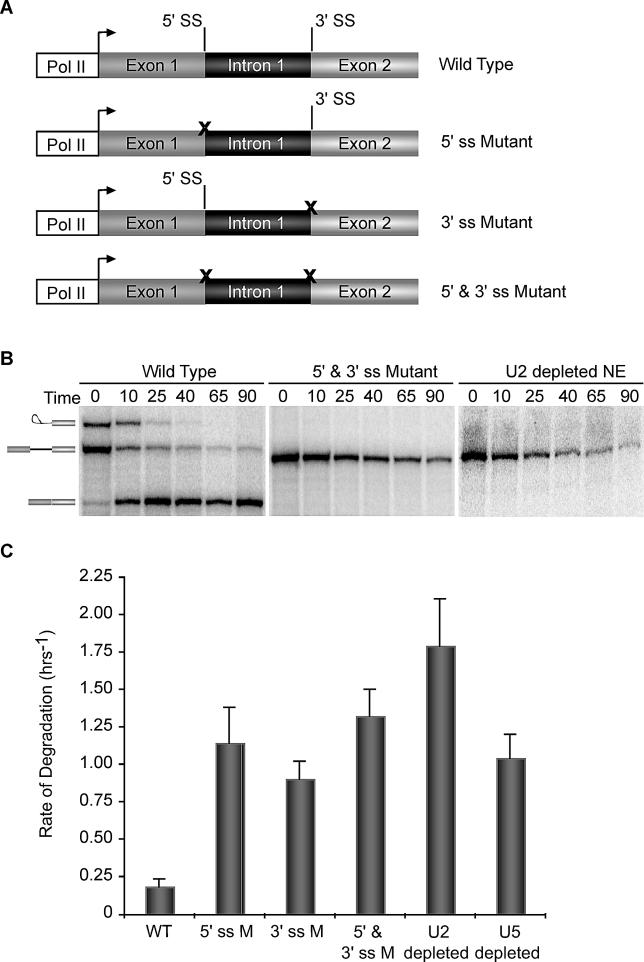
Functional Splice Sites Increase the Stability of Pol II Transcripts(A) Diagrams of DNA templates for wt (top) and mutant
β-globin minigenes. The X indicates abolished splice sites. (B) Representative autoradiograms of the transcription/splicing chase experiments for the wt substrate (left), the double 5′ and 3′ splice site mutant (ss M) (middle), the mutant substrate (middle), and the wt substrate in extracts depleted of functional U2 snRNA (right). (C) Average rates of degradation observed for the Pol II transcripts wt, 5′ ss M, 3′ ss M, the double 5′ and 3′ ss M, wt substrate in U2 snRNA depleted extract, and wt substrate in U5 snRNA depleted extract.